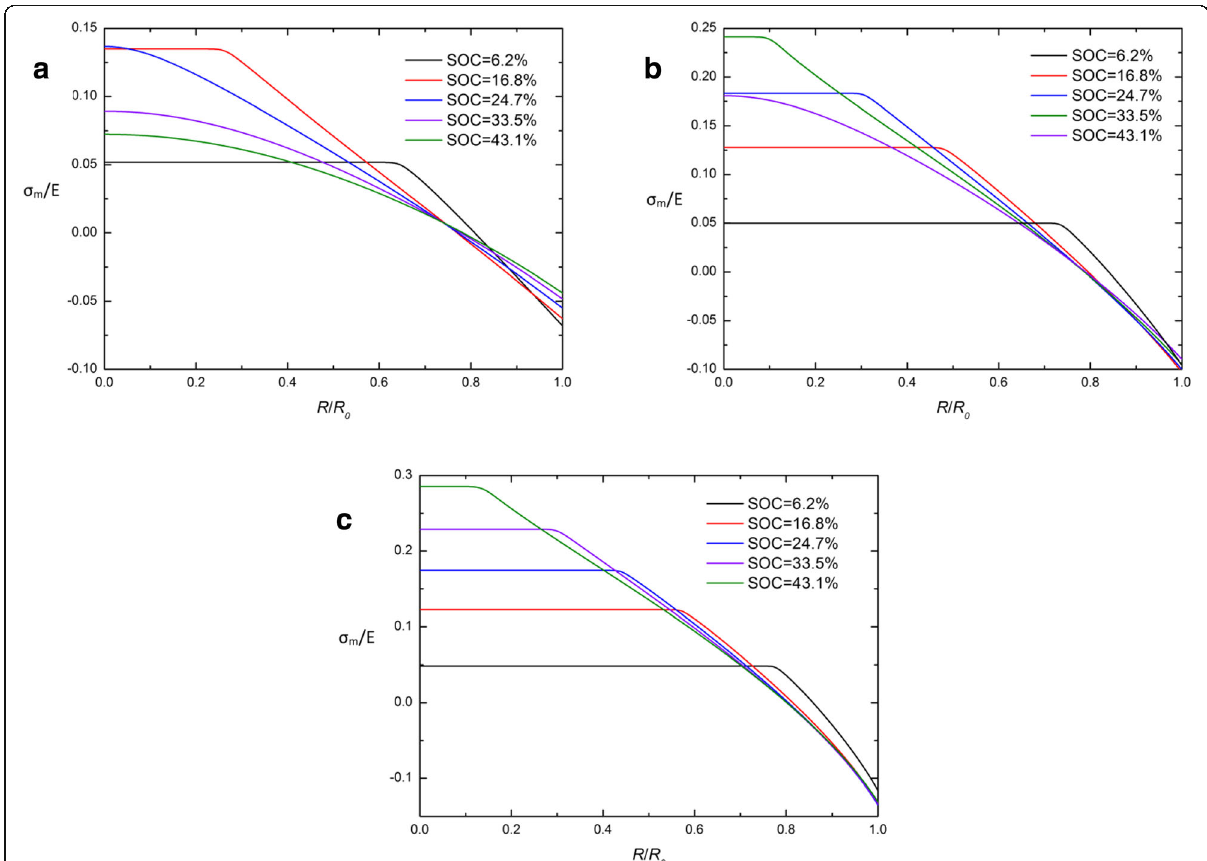
Fig. 6 Spatial distribution of σ m /E in a spherical Si nanoparticle electrode at different SOCs under galvanostatic operation with the developed expression of chemical potential ( a ) j = 0.5 j 0 , ( b ) j = j 0 , and ( c ) j = 1.5 j 0